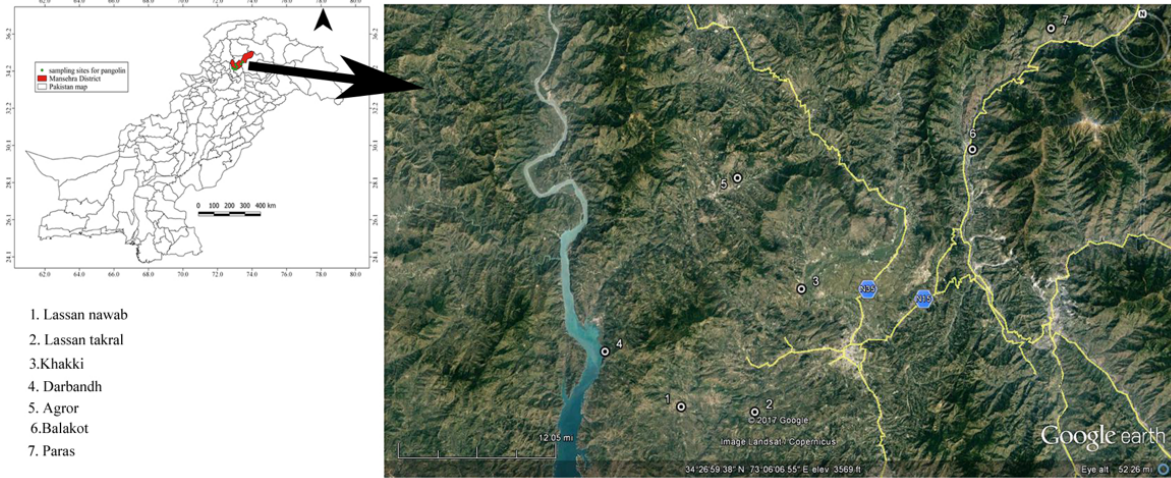
Figure 1. Map of Pakistan (inset) showing location of Mansehra District and seven selected sampling sites for Indian Pangolin Manis crassicaudata